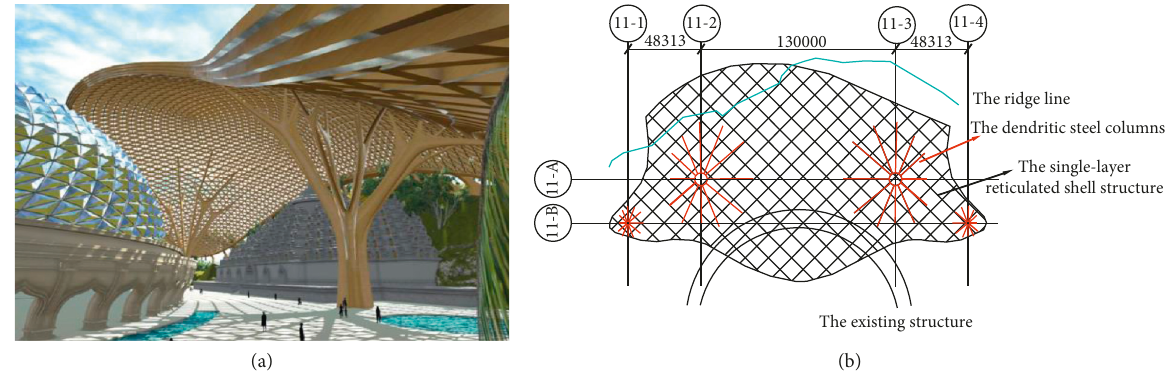
Figure 2: Schematic diagram of dendritic structure on Niushou Mountain. (a) Design sketch. (b) Plan view.